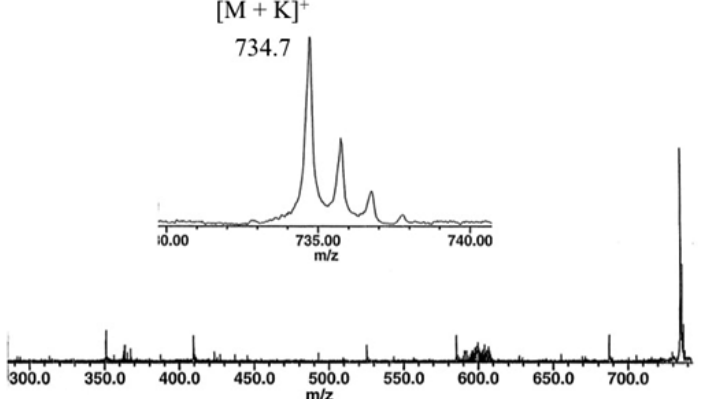
Figure 2. Direct laser desorption ionization of hexacosanoylceramide reaction mixture from EDC/HOBT coupling, reaction A. [M + K] + is observed for the product, stable isotopic distribution is in agreement for the